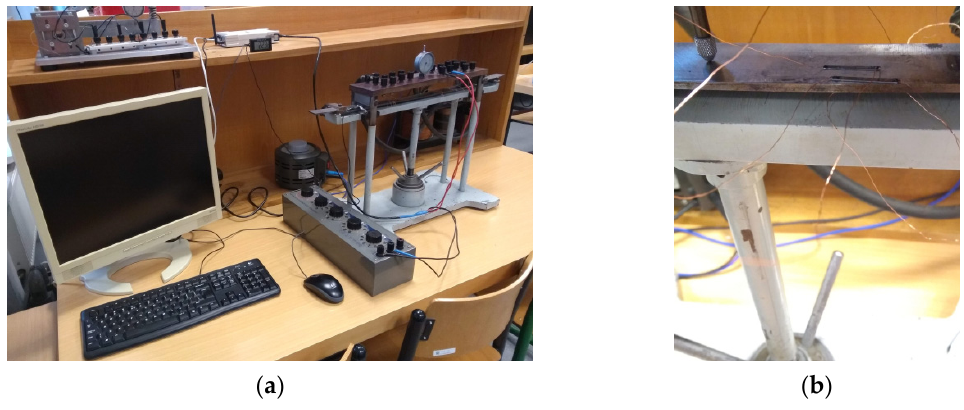
Figure 10. Laboratory setup to create and measure strain ( a ), and tested polymer sensor on the beam ( b